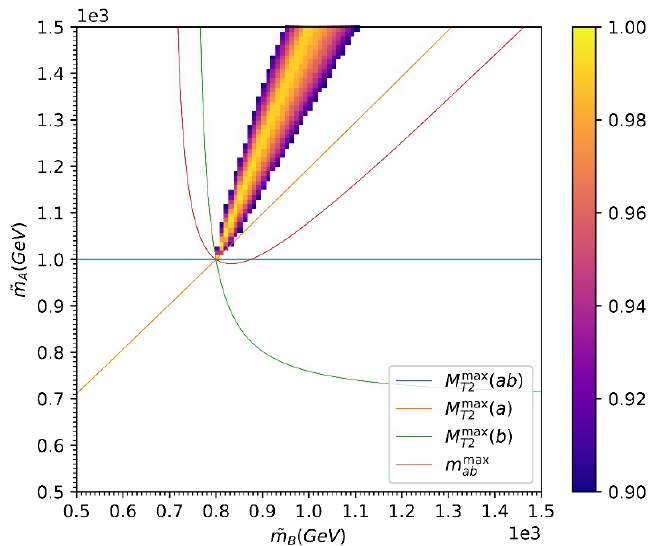
Figure 8 . Solvability heat map and constraints from measuring the kinematic endpoints (4.1): M max ( ab ) (blue), M max ( a ) (orange), M max ( b ) (green) and m max T 2 T 2 T 2 ab